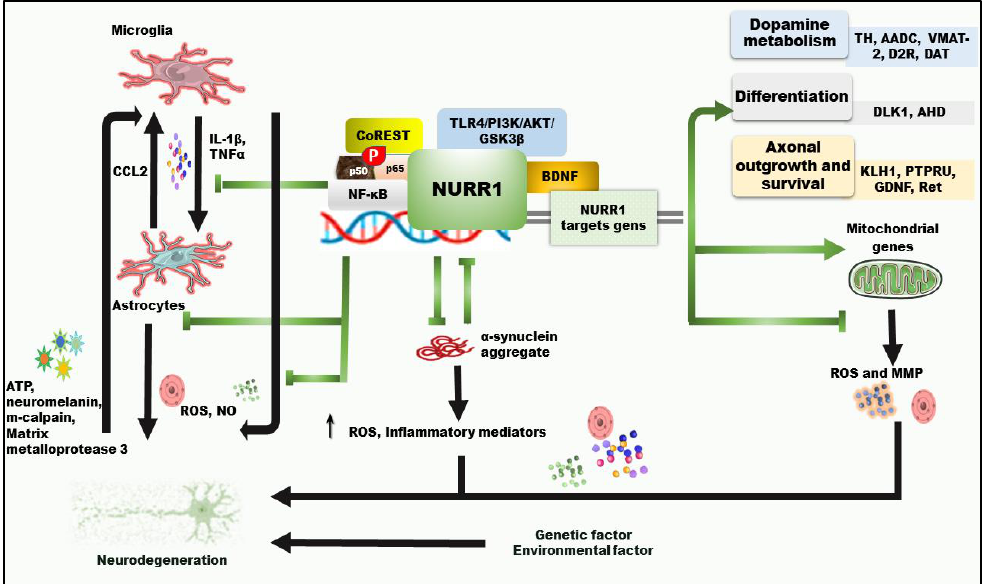
Figure 2. NURR1-regulated Neuroinflammation associated with PD. The green arrows indicate the regulatory mechanism of NURR1: “sharp head (positive regulation), blunt head (negative regula- tion).” The black arrows are the main inflammatory pathways; NURR1 is involved in PD. α -Synuclein and NURR1 have a bidirectional effect. α -Synuclein boosts inflammatory mediators and free radicals, enhancing α -synuclein aggregation, resulting in a vicious cycle. NURR1 positively regulates several nuclear-encoded mitochondrial genes and protects cells from mitochondrial mem- branes and ROS. Abbreviations: ATP: adenosine triphosphate; CCL2: chemokine ligand 2; MMP: mitochondrial membrane potential; NURR1: nuclear receptor-related transcription factor 1; ROS: reactive oxygen species.